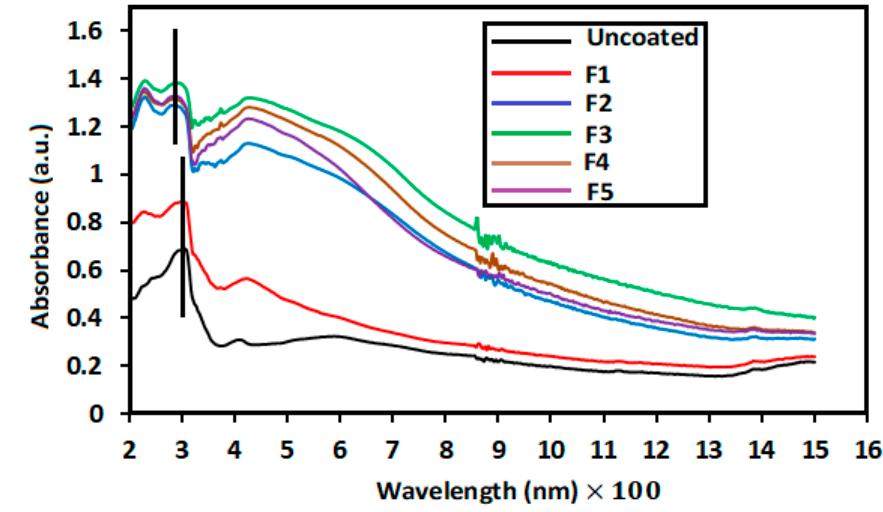
Figure 4. UV–Vis absorbance spectra of the samples.